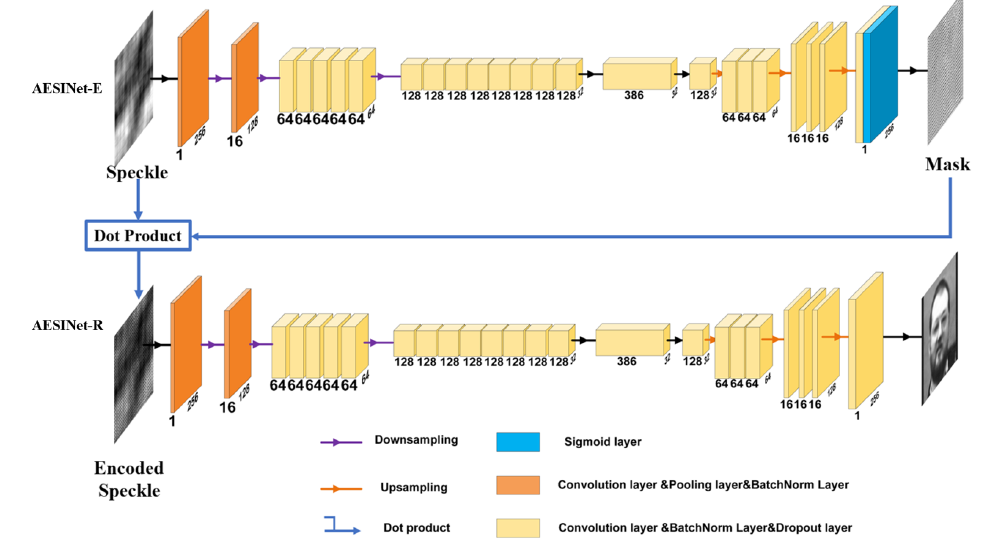
Figure 1. Network structure diagram of